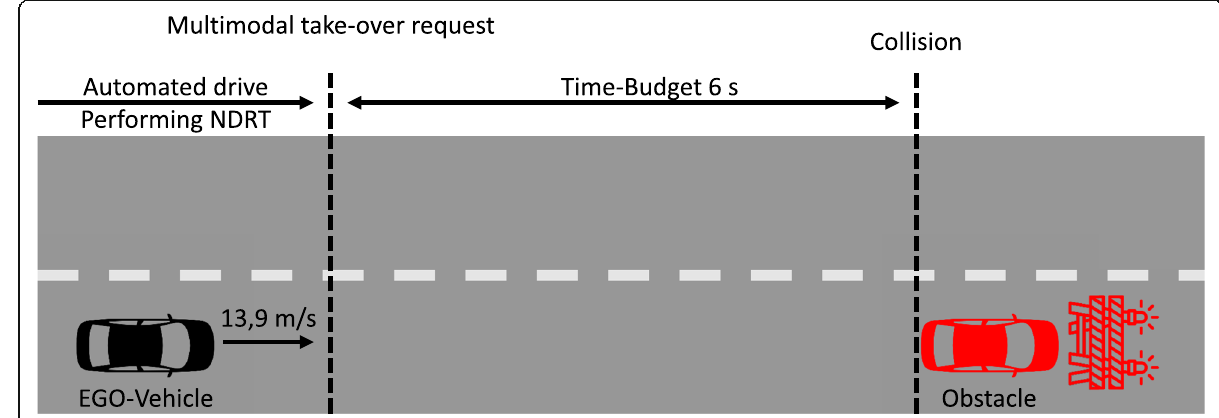
Fig. 3 Example of the TOR situation. Left: simulation view. Right: schematic representation from bird ’ s eye